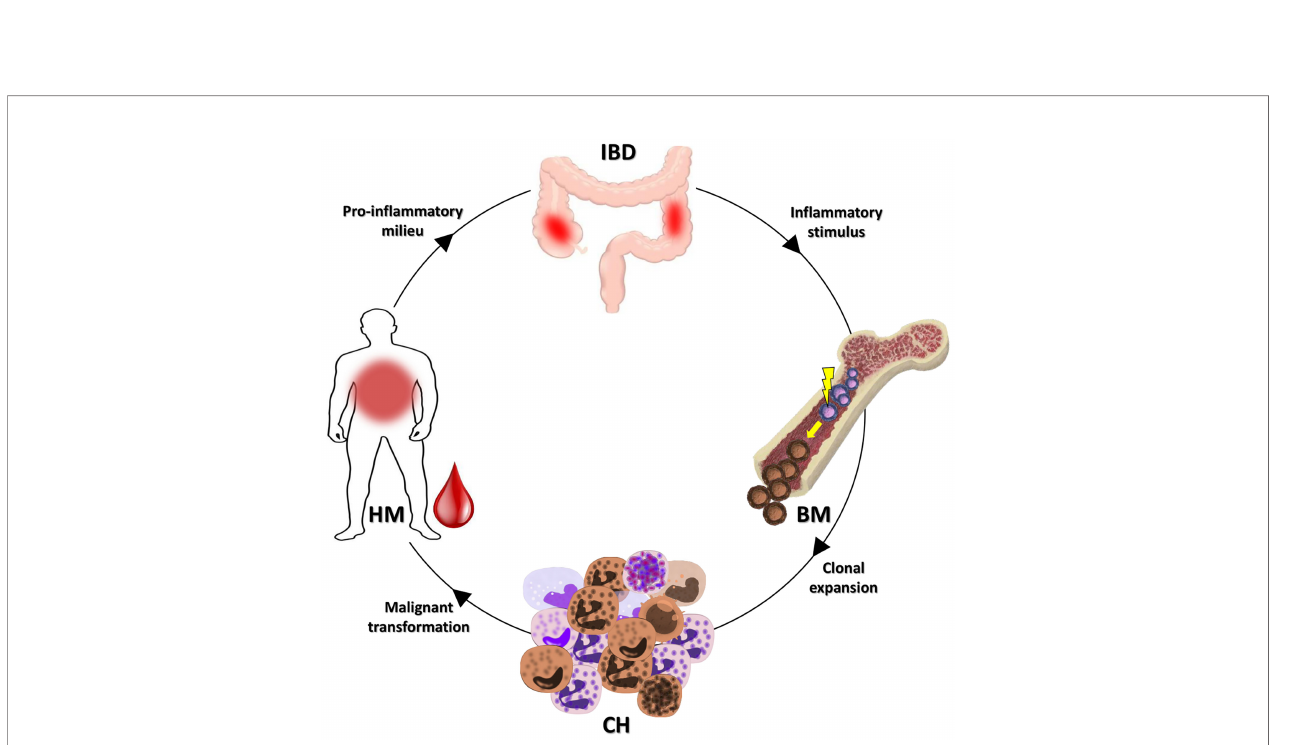
FIGURE 2 | Possible link between IBDs and HMs. As demonstrated, an IBD may promote the CH onset (14). The clone selected could evolve in a subsequent HM or favor the insurgence of an HM. In both cases, the in fl ammatory milieu of the HM may, in turn, feed the IBD. IBD, in fl ammatory bowel disease; BM, bone marrow; CH, clonal hematopoiesis; HM, hematological malignancy.